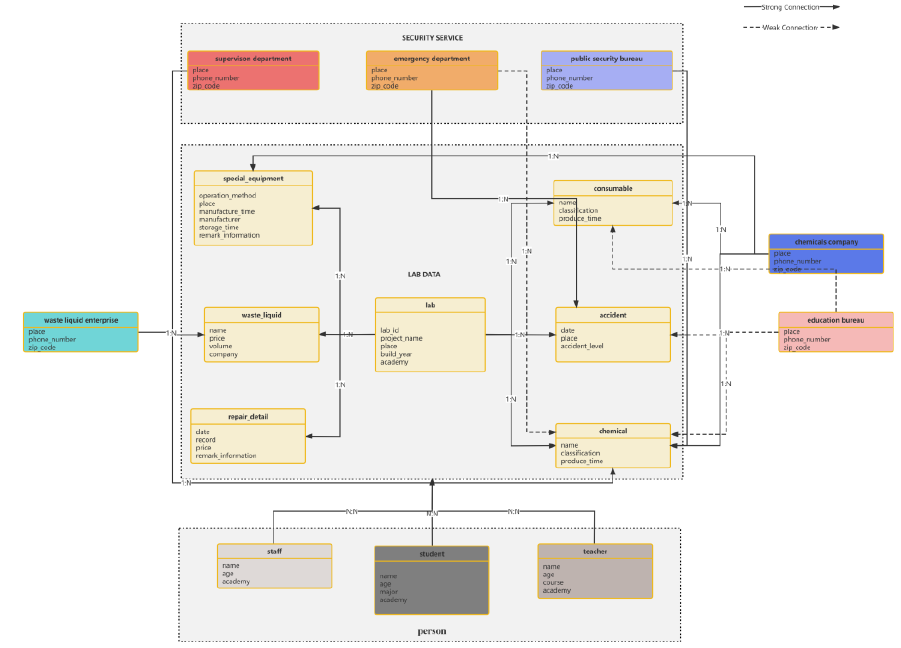
Figure 6. The whole structure of laboratory management is based on DOSA.